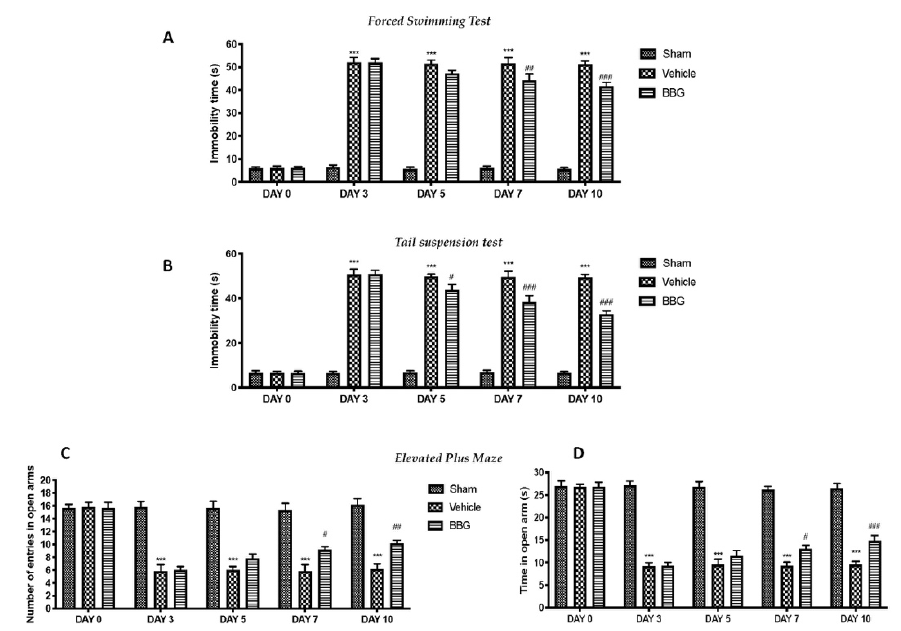
Figure 6. Behavioral analysis: forced swimming test ( A ), tail suspension test ( B ) and elevated plus maze test (time in open arms ( C ) and number of entries ( D )). Data are representative of at least three independent experiments and are expressed as mean ± SEM from N = 6 rats/group. *** p < 0.001 vs. sham; # p < 0.05 vs. vehicle; ## p < 0.01 vs. vehicle; ### p < 0.001 vs. vehicle.